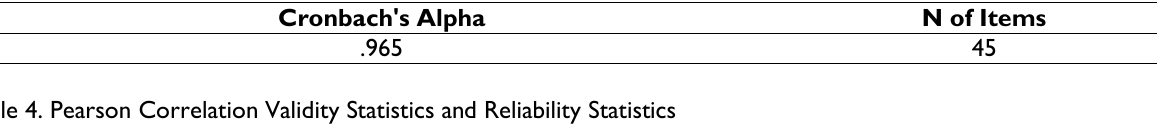
Table 3. Reliability Statistics